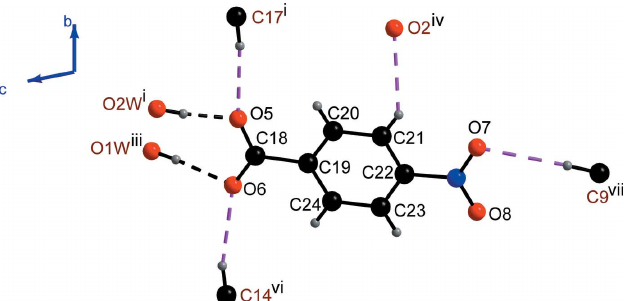
Figure 2 The hydrogen-bonding scheme around the 4-nitrobenzoate anion showing the O—H (cid:2)(cid:2)(cid:2) O and C—H (cid:2)(cid:2)(cid:2) O hydrogen bonds as dashed lines. For symmetry codes see Table 1.